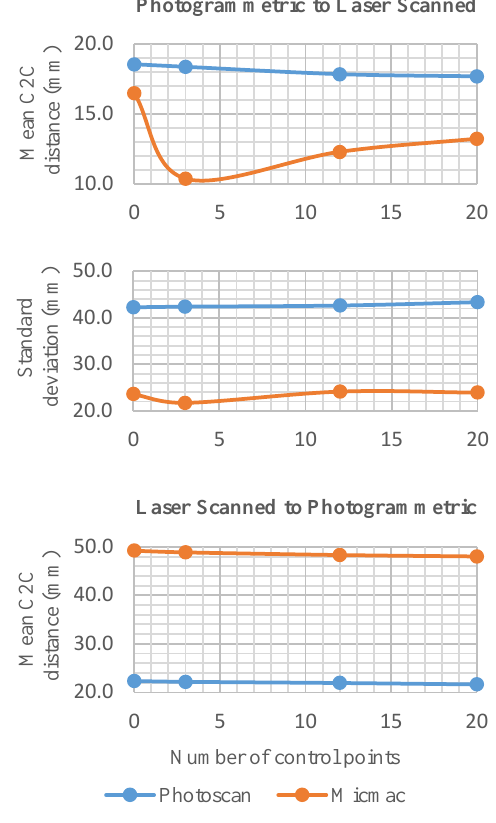
Figure 7. C2C distance testing of point clouds in Photoscan and MicMac